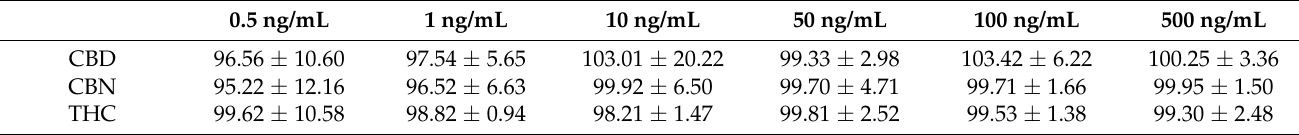
Table 6. Recovery of cannabinoids from Moringa oleifera ( n = 3) (mean ± SEM). 0.5